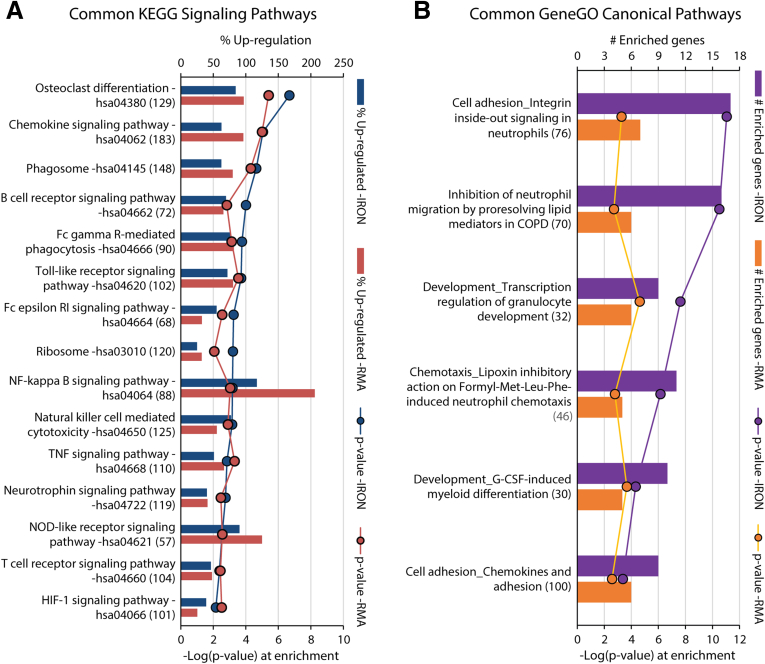
Association between environmental enteric dysfunction and inflammatory transcripts and pathways. (A) Thirteen common KEGG pathways identified within both RMA- and IRON-normalized microarray intensity data. Numbers after the titles of pathways in parentheses are the number of genes in the data set that were mapped to the given pathways. The significant genes shown are those with an absolute fold-change greater than 1.1 at P < .05 in differential analysis. The percentage of up-regulation was calculated using mean fold-change values of significant genes divided by mean fold-change values of nonsignificant genes on the pathways. The -log10 (P value) was from pathway analysis, indicating the statistical significance. (B) There are 6 common canonical pathways identified using both IRON- and RMA-normalized microarray data. The analysis was performed on genes with a significant correlation between signal intensity and %L value at P < .01. The numbers following the titles of pathways are the number of genes in the maps of given pathways. These pathways were significant at P < .01 and a false-discovery rate less than 0.25, and the log (P values) are shown in the dotted red lines. The genes with positive correlation coefficients are shown in gold, and the genes with negative correlation coefficients are shown in blue. COPD, chronic obstructive pulmonary disease; Fc, fragment crystallizable region; HIF-1, hypoxia-inducible factor 1; NF, nuclear factor; NOD, nucleotide-binding oligomerization domain; RI, Fc epsilon RI or high-affinity IgE receptor; TNF, tumor necrosis factor.